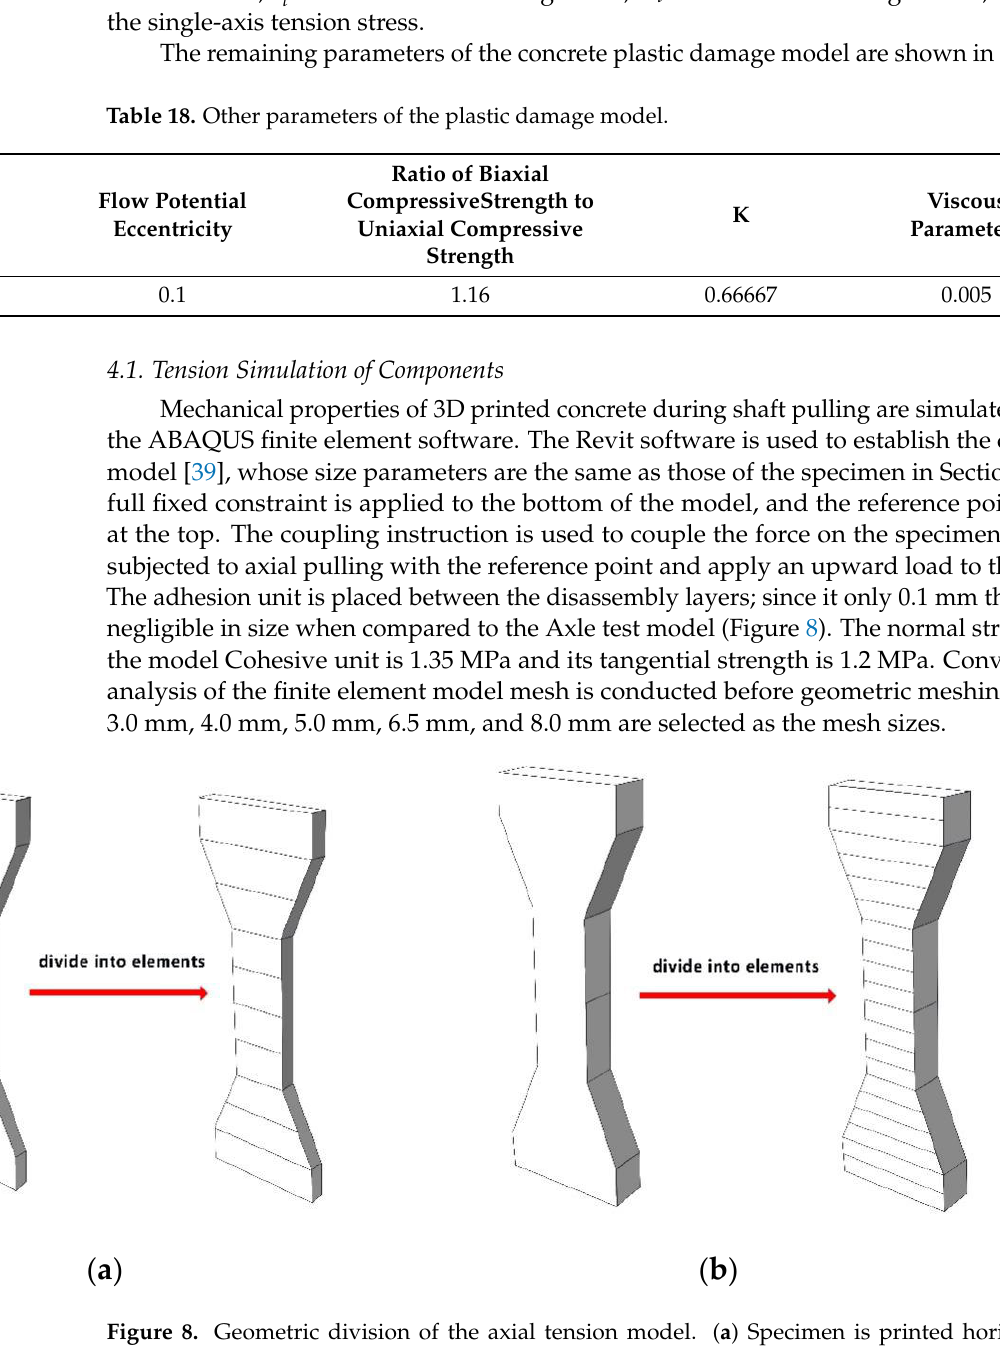
( b ) Figure 9. Analysis of grid convergence in the axial tension model. ( a ) Calculation results ; ( b ) Axial tension model subjected to meshing . Numerical simulations show that the bond layer of 3D printed concrete breaks under vertical tension, which is consistent with the fracture pattern of the uniaxial tension test in Section 3.5. By calculating the reaction force at the reference point, the tension strength of the horizontally and vertically printed structures is determined to be 1.35 MPa and 1.48 MPa, respectively. The simulated and experimental results have been compared in Figure 10 and Table 19. The average tension strength of horizontally printed specimens is 1.41 MPa, which is greater than the simulated value by 4.4%. Meanwhile, the average tension strength of ver- tically printed specimens (1.56 MPa) is greater than the simulated value by 5.4%. This may